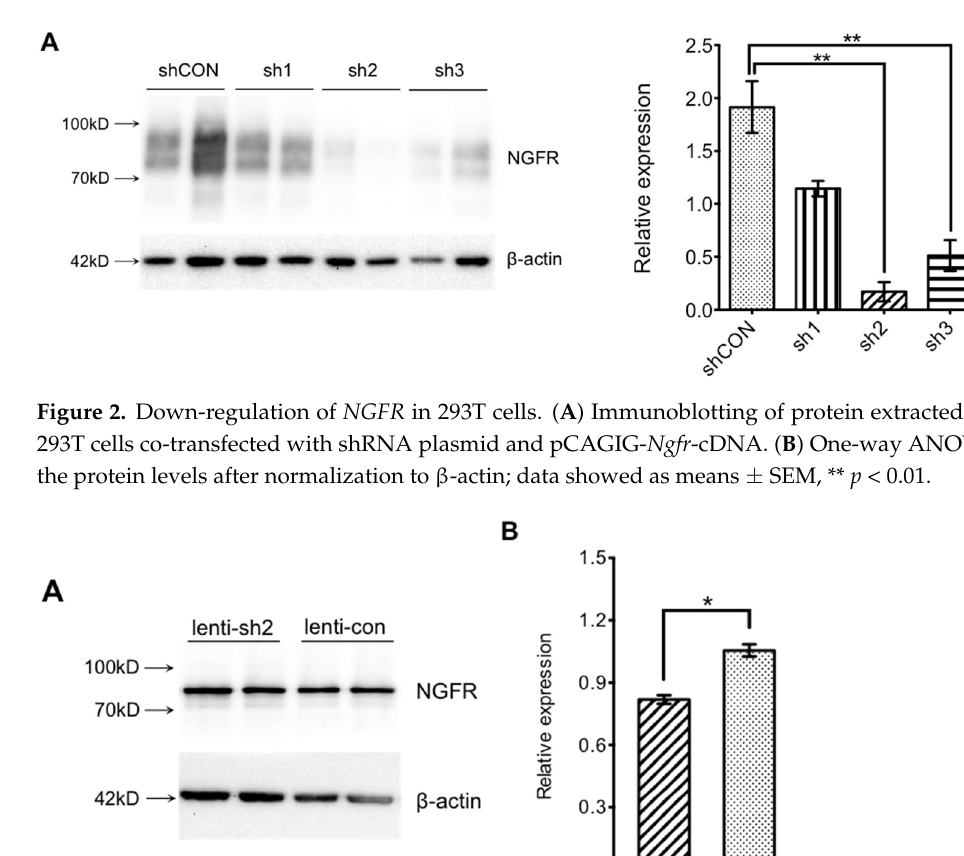
Figure 1. GFP expressed by the transfected cells. The 293T cells were co-transfected with shRNA plasmid and pCAGIG- Ngfr -cDNA.